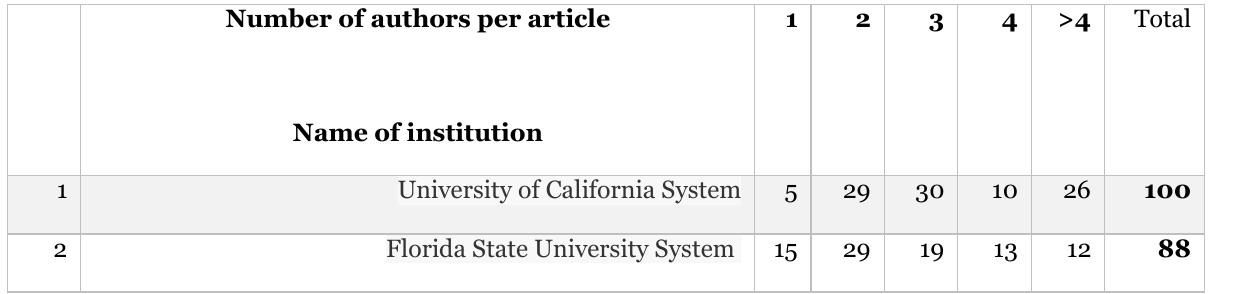
Collaboration Rate of Authors at Institutions Prolific in E-learning